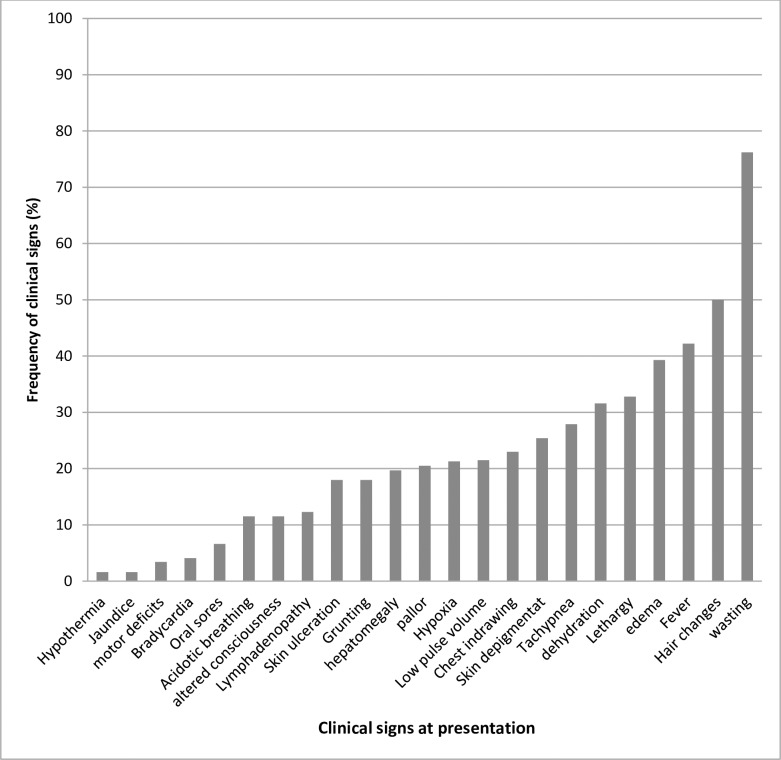
Presenting clinical signs of the partcipants at admission.